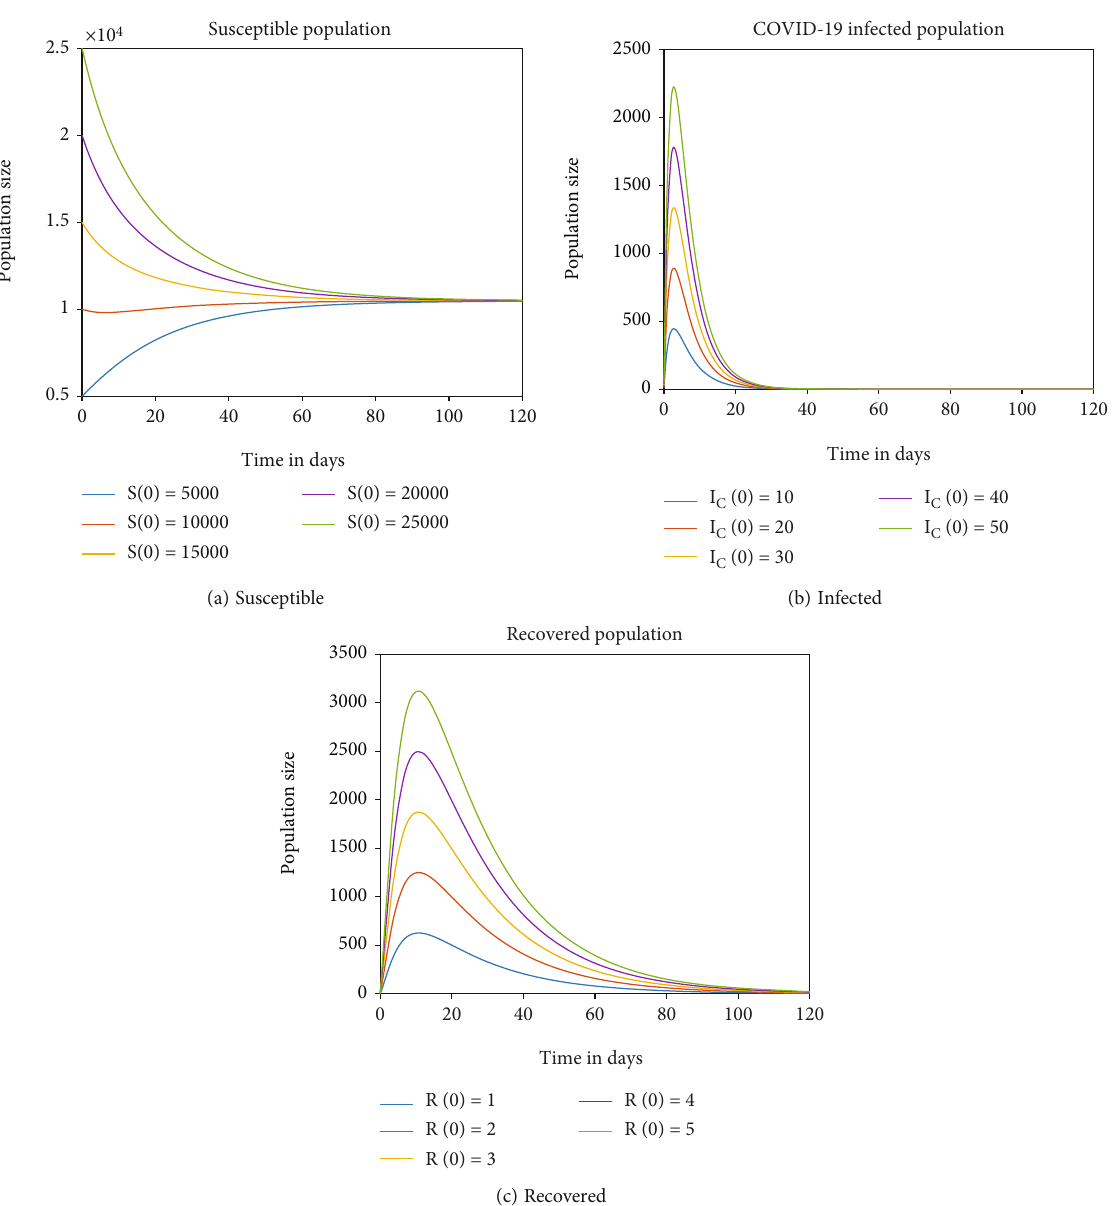
Figure 3: The solution curves of the susceptible, infected, and recovered populations for di ff erent initial values of the COVID-19 only model with R C 0 = 0 : 2524 < 1